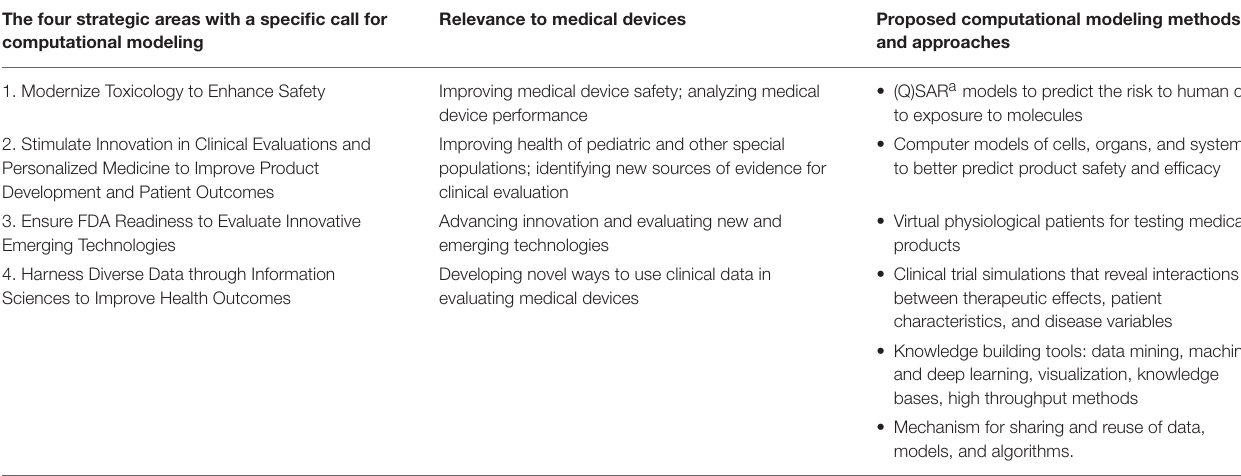
TABLE 1 | In 2011, FDA identified an important role for computational modeling in its strategic